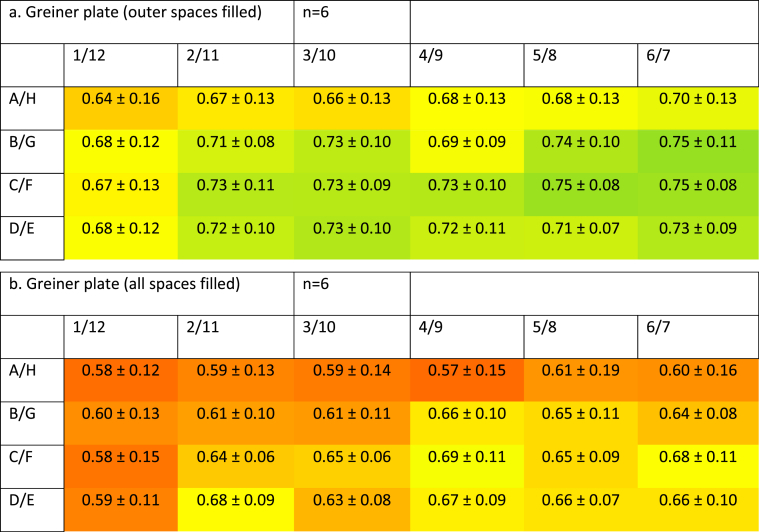
Profile of metabolic activity of cells grown in Greiner plates with added buffer between the wells. SW480 cells were grown for 72 h before being subjected to an MTS proliferation assay. Data show absorbance (490 nm) increase and standard deviation of sample data following a 2-h incubation in the presence of MTS reagent and represent n = 6.4a: only outer spaces filled. 4b: all spaces between wells filled.